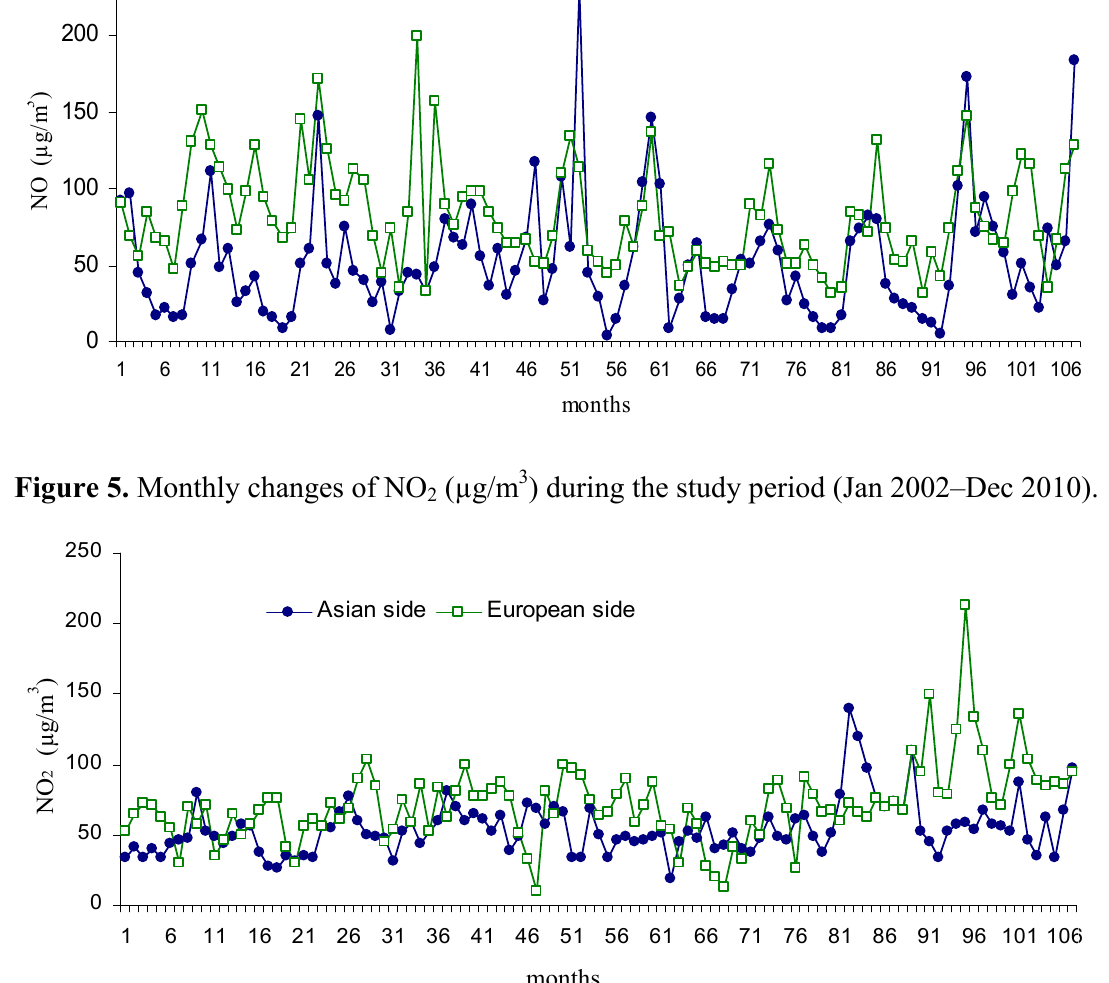
Figure 4. Monthly changes of NO (µg/m 3 ) during the study period (Jan 2002–Dec 2010).